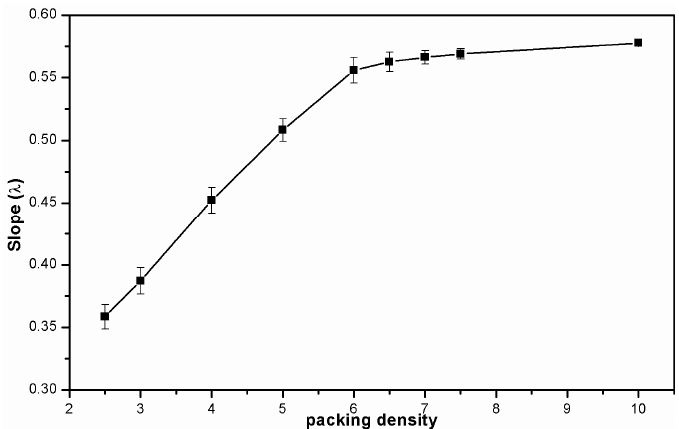
Figure 12. Dynamic changes in λ with different packing densities (with error bars).